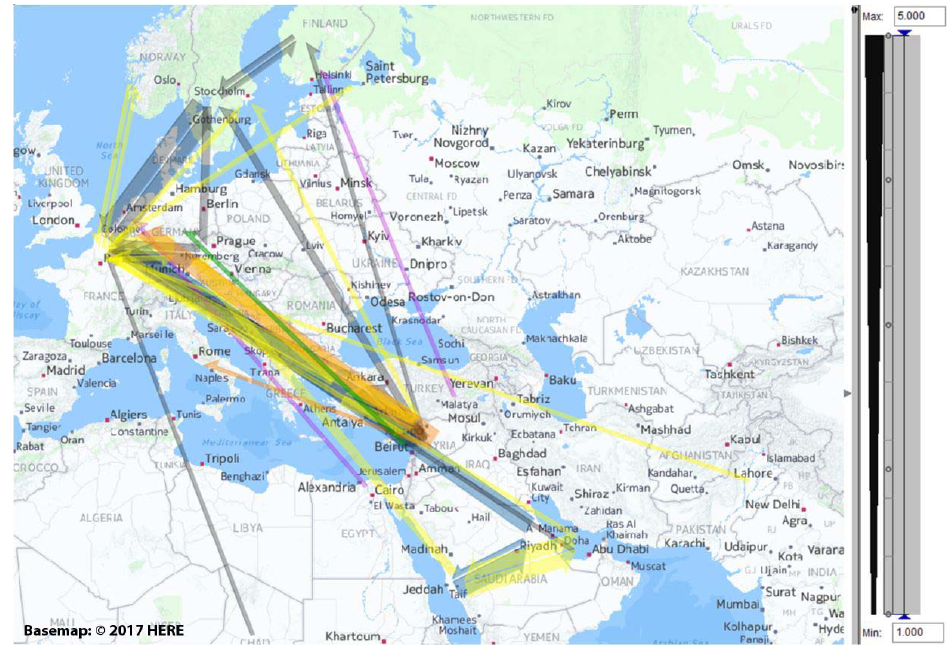
Figure 7. Aggregated routes to Europe for different user types: business (blue), journalist (dark grey), tourist (yellow), potential refugee (orange), likely refugee (green), and other (magenta). ISPRS Int. J. Geo-Inf. 2017 , 6 , 302